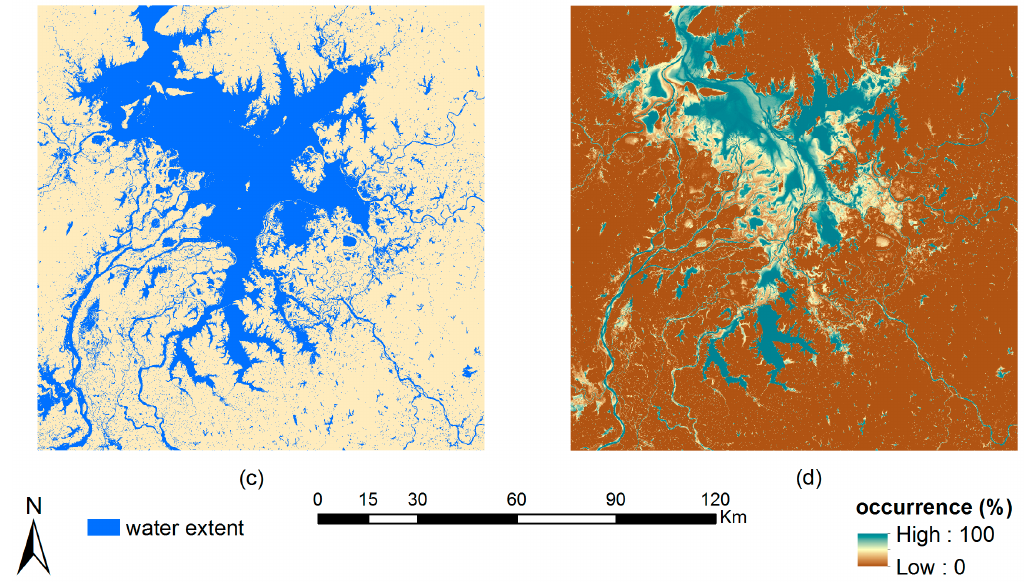
Figure 2. ( a ) Water extent of Yunnan lakes; ( b ) water occurrence of Yunnan Lakes; ( c ) water extent of Poyang Lake, and ( d ) water occurrence of Poyang Lake, extracted from the global water dynamic dataset published by Pekel et al. [24].